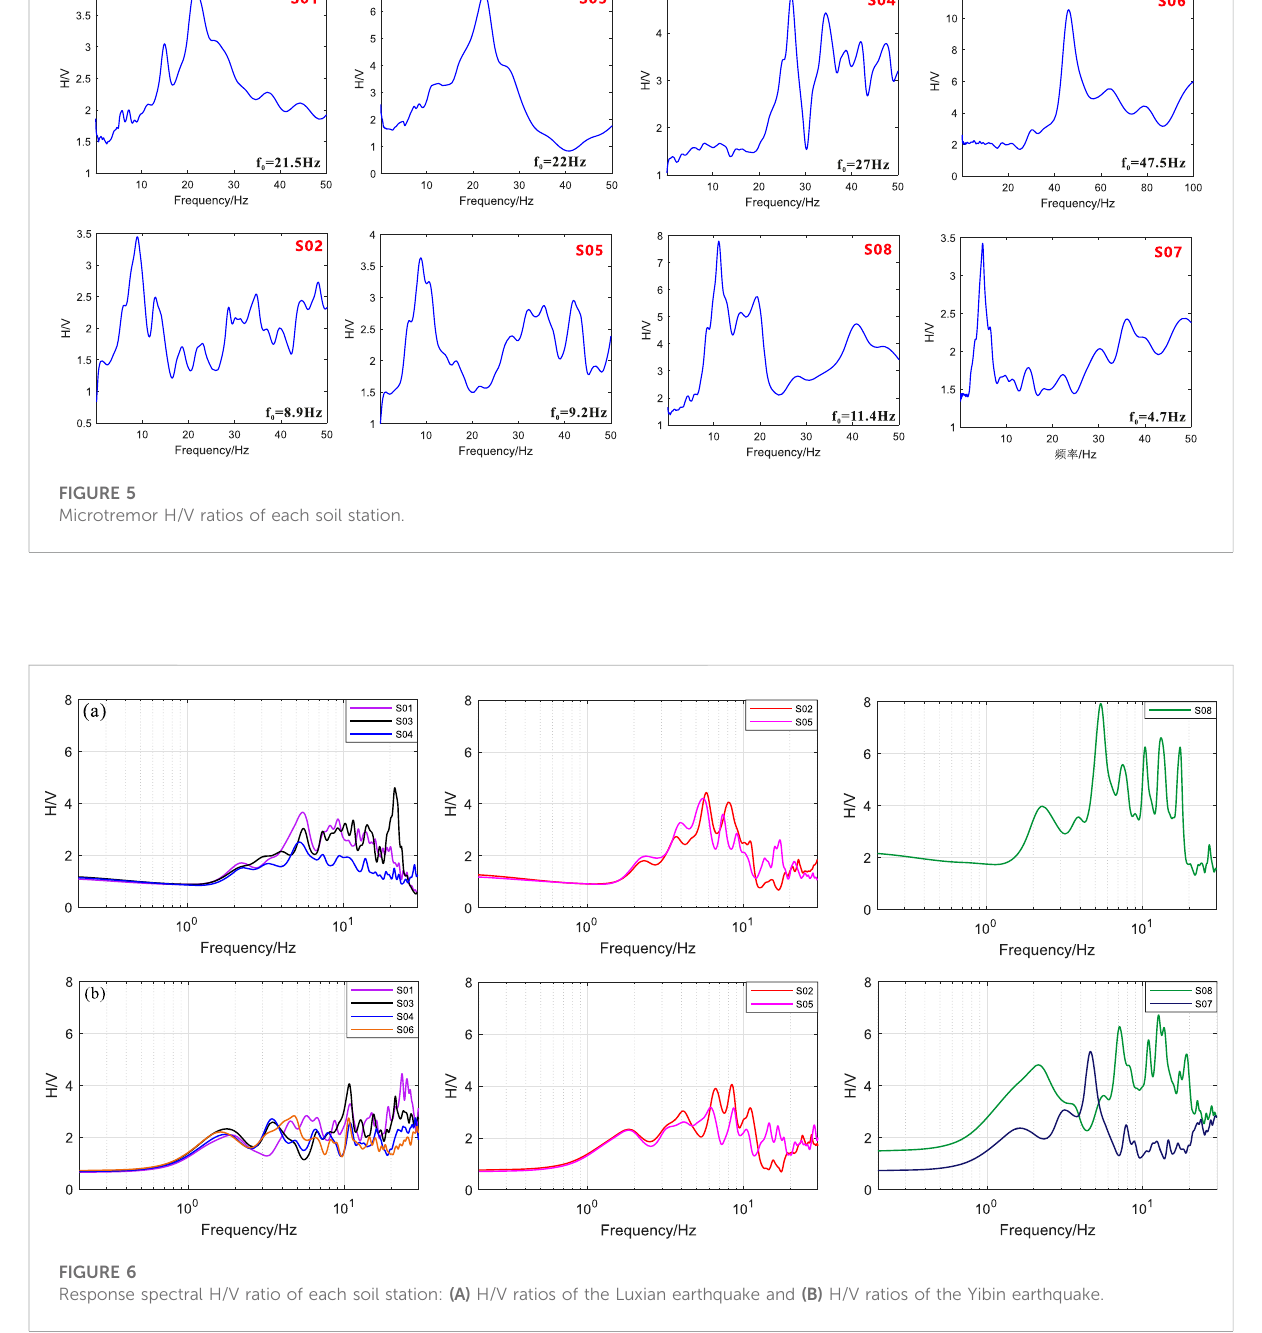
curve. The spectral ratio curve of S08 is the most distinctive. For S08,